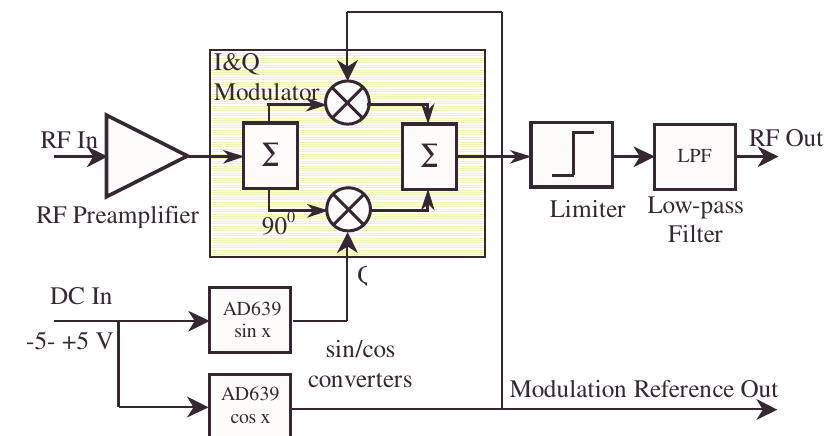
FIG. 6. (Color) Block diagram of a 360 (cid:1) linear phase shifter. Minicircuits MIQC-60WD I&Q demodulator and analog devices AD639 trigonometric converters provide high linearity of the phase control curve.